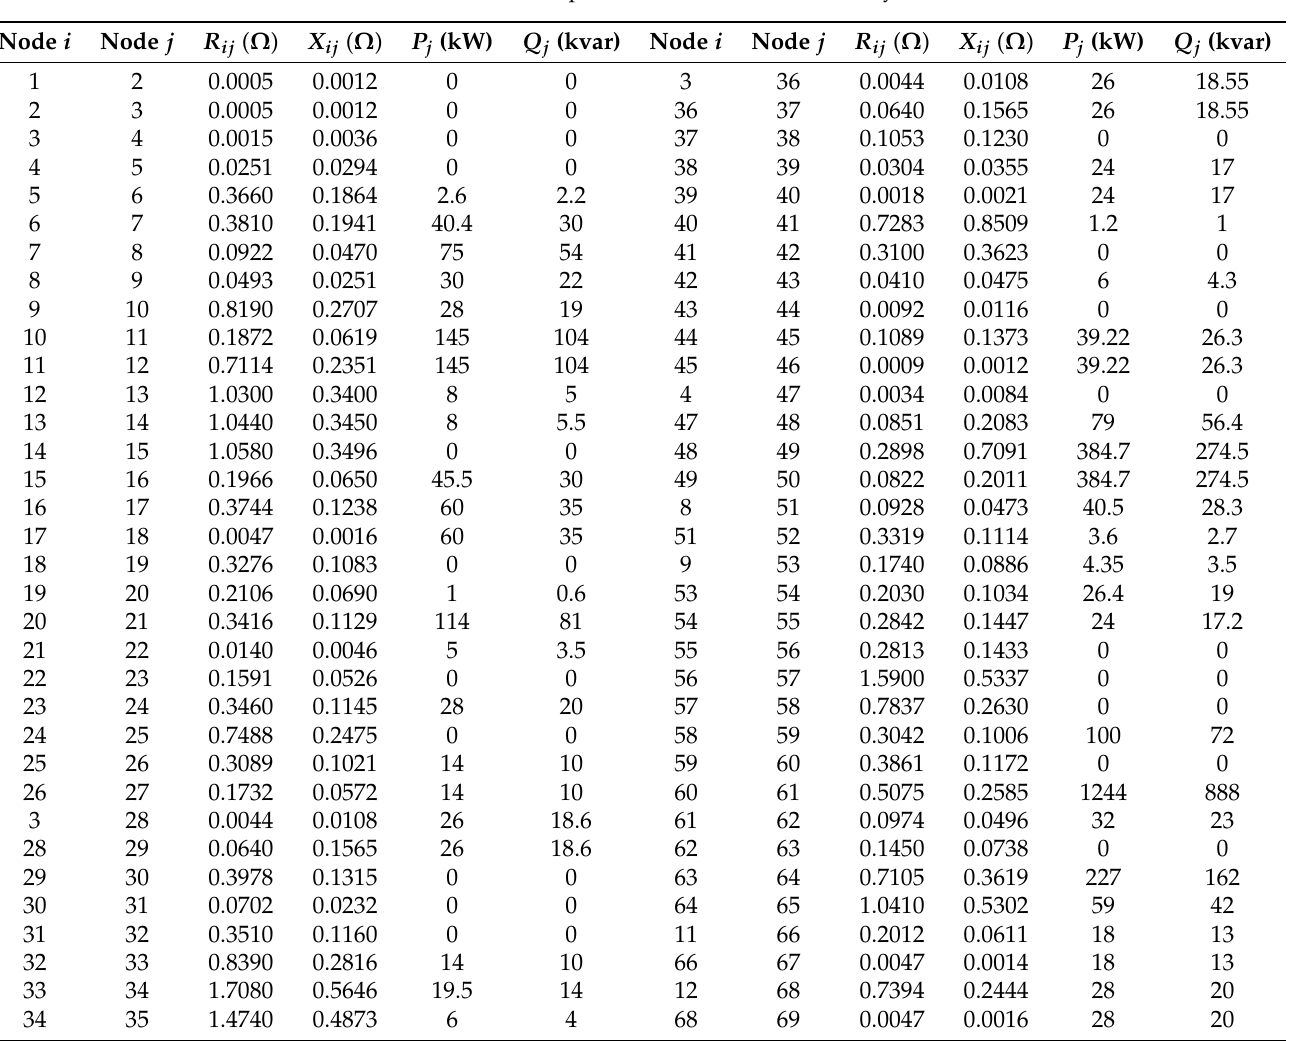
Table 2. Branch and load parameters of the IEEE 69-bus